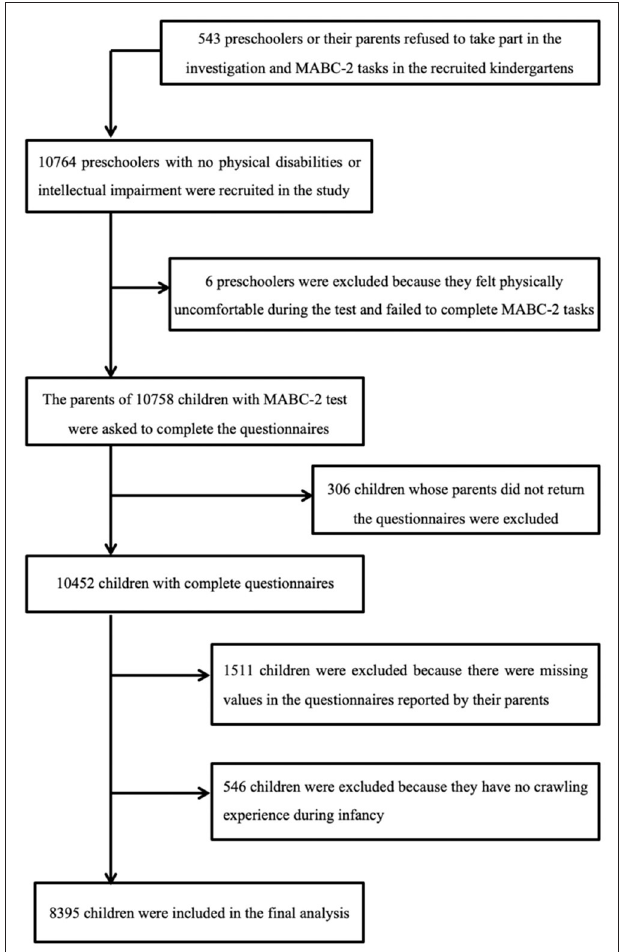
FIGURE 1 | Flowchart of the study